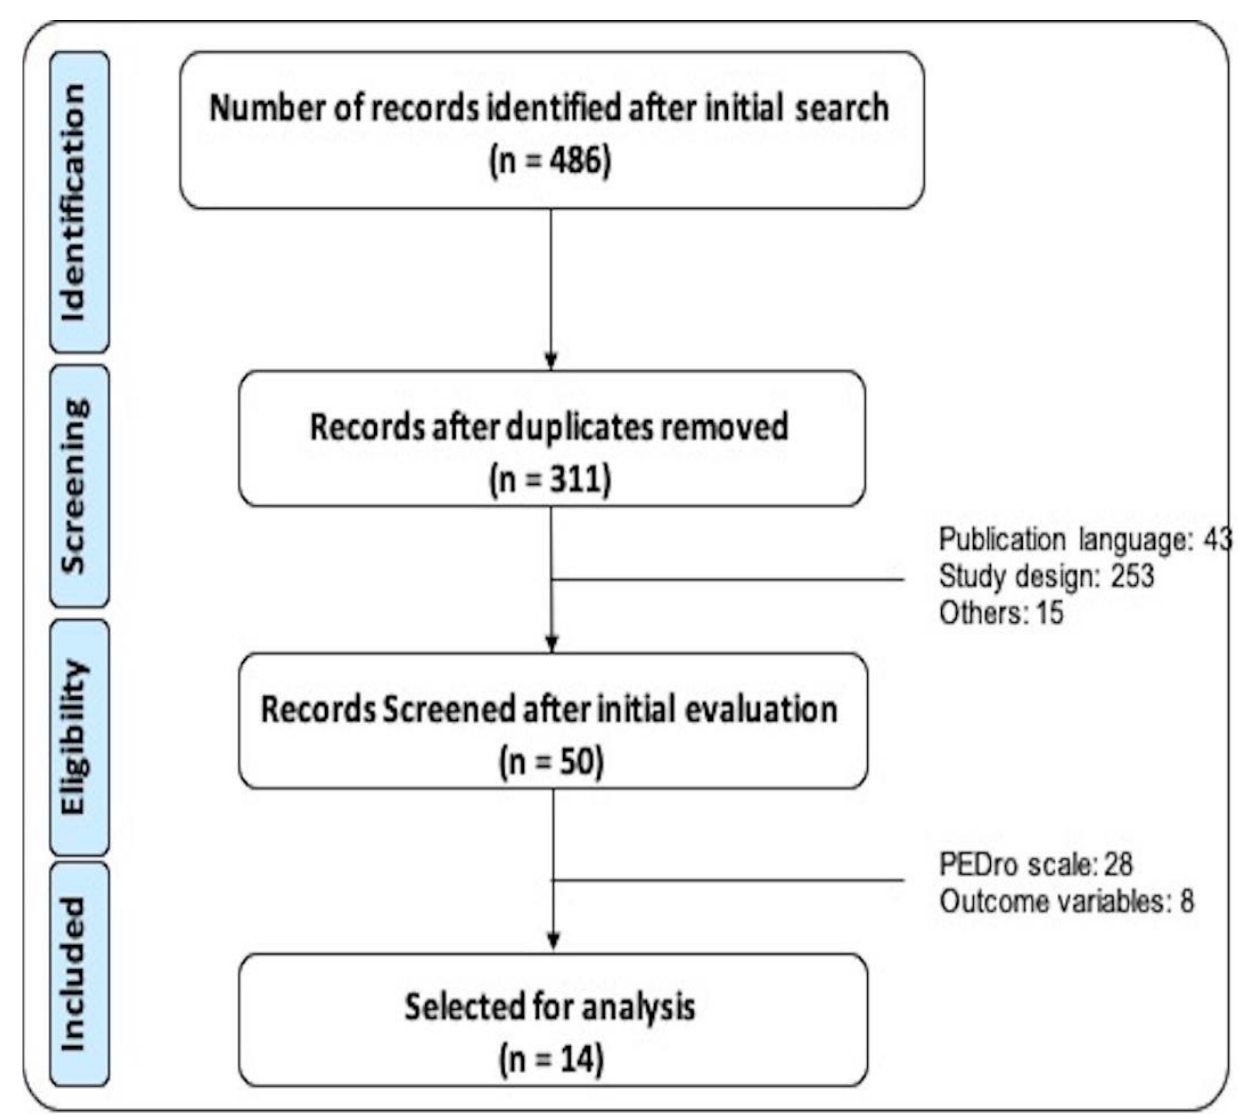
Figure 1. Search, filtering and selection flowchart of the documents included in this systematic re- view.